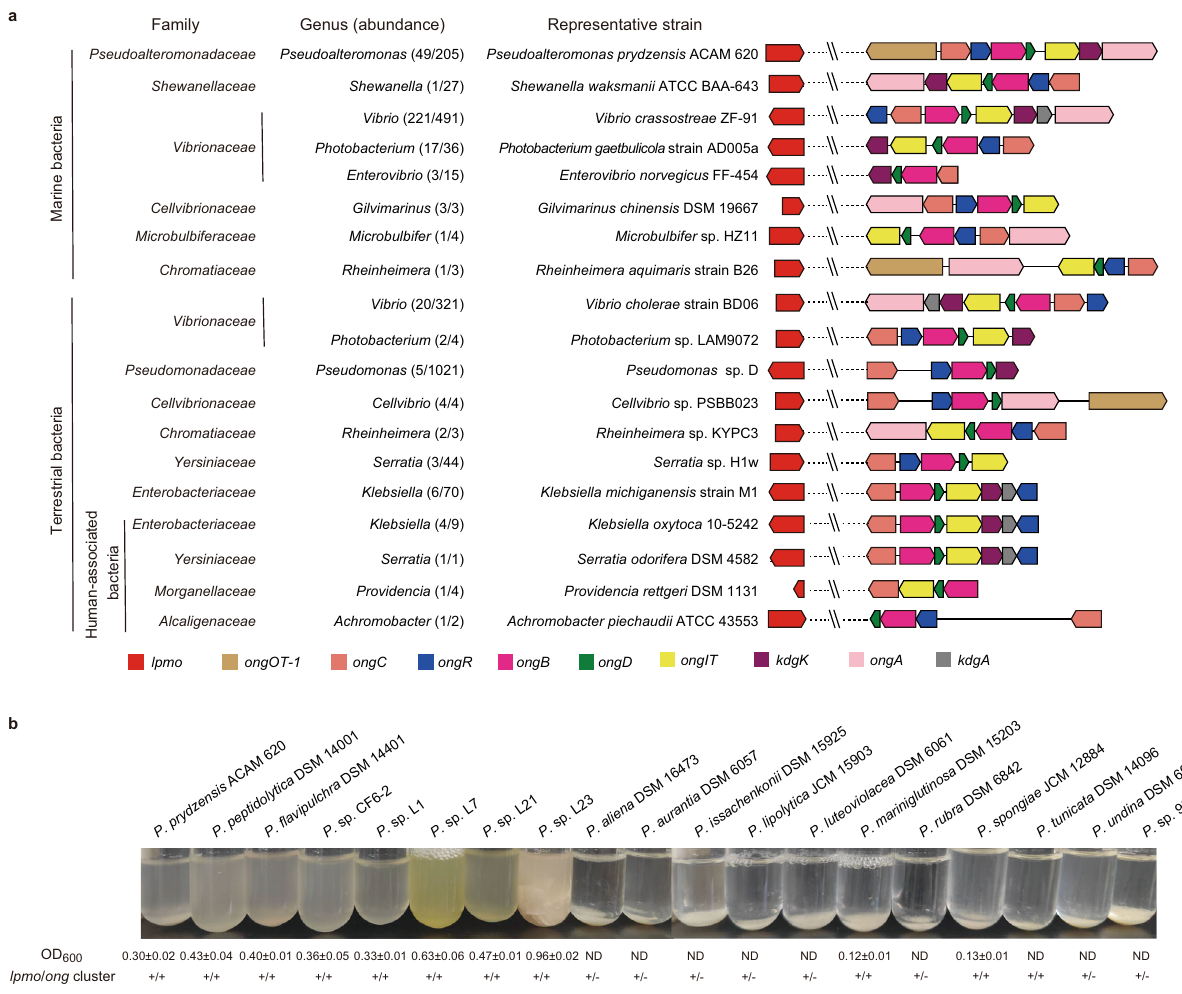
α -chitin as the sole carbon source at 25°C for 7 days. No bacterial growth was detectable for nine Pseudoalteromonas strains including P. aliena DSM 16473, P. aurantia DSM 6057, P. issachenkonii DSM 15925, P. lipolytica JCM 15903, P. luteo- violacea DSM6061, P.rubra DSM6842, P.tunicata DSM14096, P.undina DSM6065 and P .sp.SM9913,eventhoughtheywerecultivatedon α -chitinfor14daysat25°C. ND, undetectable growth; +, presence; -, absence. Growth data are presented as mean±SD ( n =3 independent experiments). Source data are provided as a Source Data fi